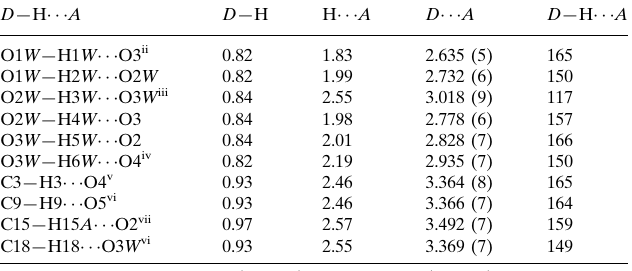
Hydrogen-bond geometry (A˚ , (cid:2) ). D —H (cid:1)(cid:1)(cid:1)